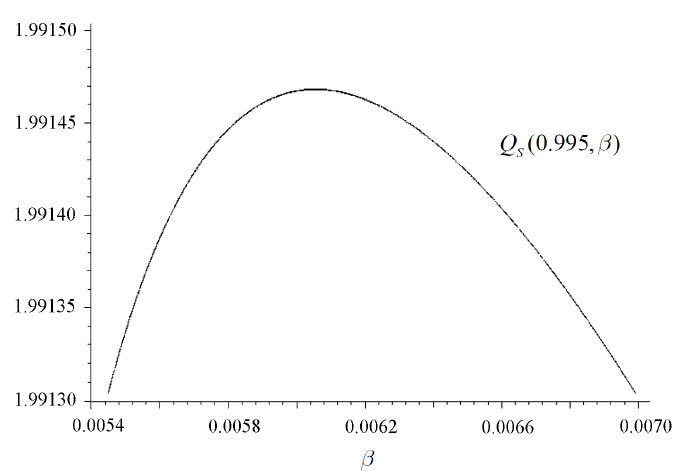
(0.995, β ) in Example 2. S